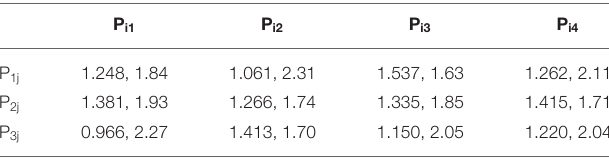
TABLE 3 | Optimal influence coefficient χ and simulated peak loads ( N ) for each indentation